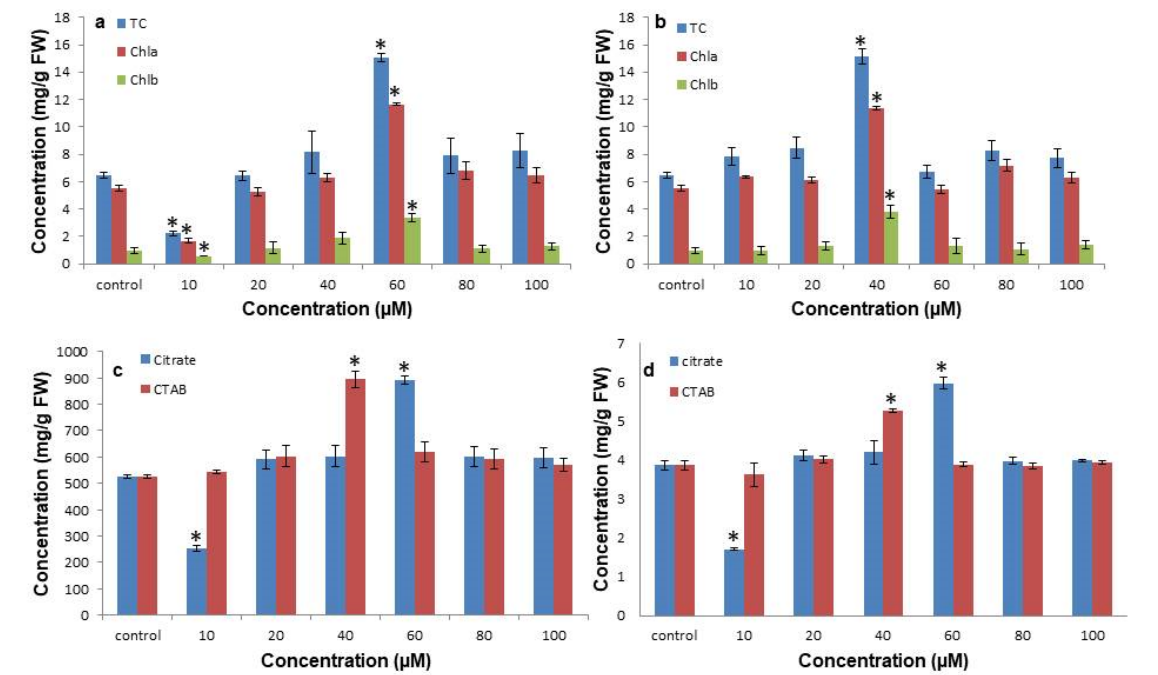
Figure 4. Effect of citrate-AuNPs and CTAB-AuNPs on in vitro photosynthetic pigment and total soluble sugar content in N. jatamansi . ( a ) The effect of citrate-AuNPs on the total chlorophyll, chlorophyll a and b content; ( b ) effect of CTAB-AuNPs on the total chlorophyll, chlorophyll a and b content; ( c ) effect of citrate-AuNPs and CTAB-AuNPs on the carotenoid content; ( d ) effect of citrate-AuNPs and CTAB-AuNPs on the total soluble sugar content. Error bar represents the standard error of three biological replicates. * Indicates significantly reduced and enhanced concentrations in comparison to the control.